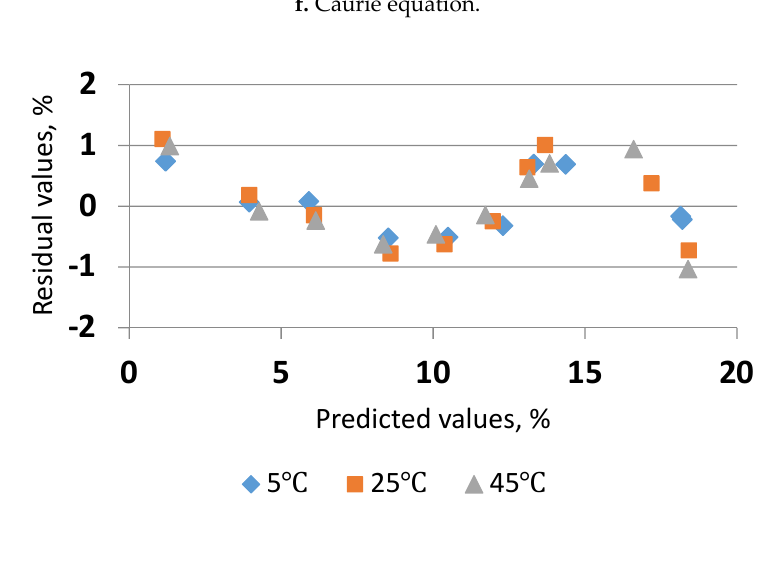
g. GAB equation. Figure 3. Residual plots for the sorption isotherm equations for sorption data of C. morifolium flowers obtained at three temperatures. ( a ) Henderson eq., ( b ) Chung-Pfost eq., ( c ) Halsey eq., ( d ) Oswin eq., ( e ) White & Eirig eq., ( f ) Caurie eq., ( g ) GAB eq. Table 3. Estimated parameters and evaluating criteria of six models used for adsorption data at five temperatures for C. morifolium flowers. Temp. 5 ◦